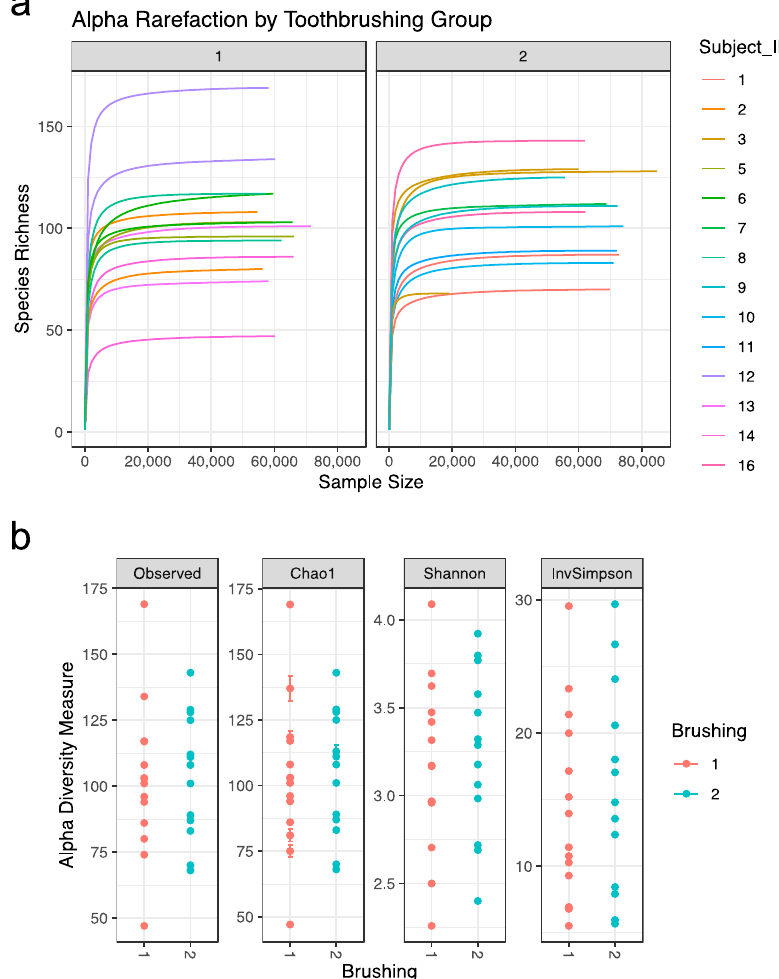
Figure 2. Sample alpha diversity: ( a ) Alpha Rarefaction by brushing group. Rarefaction curve for each subject. ( b ) Alpha diversity measures by brushing group. Abbreviations: Observed = Observed ASV; InvSimpson = inverse Simpson. Tooth brushing groups: brush1: once a day (red); brush2: twice a day (blue).